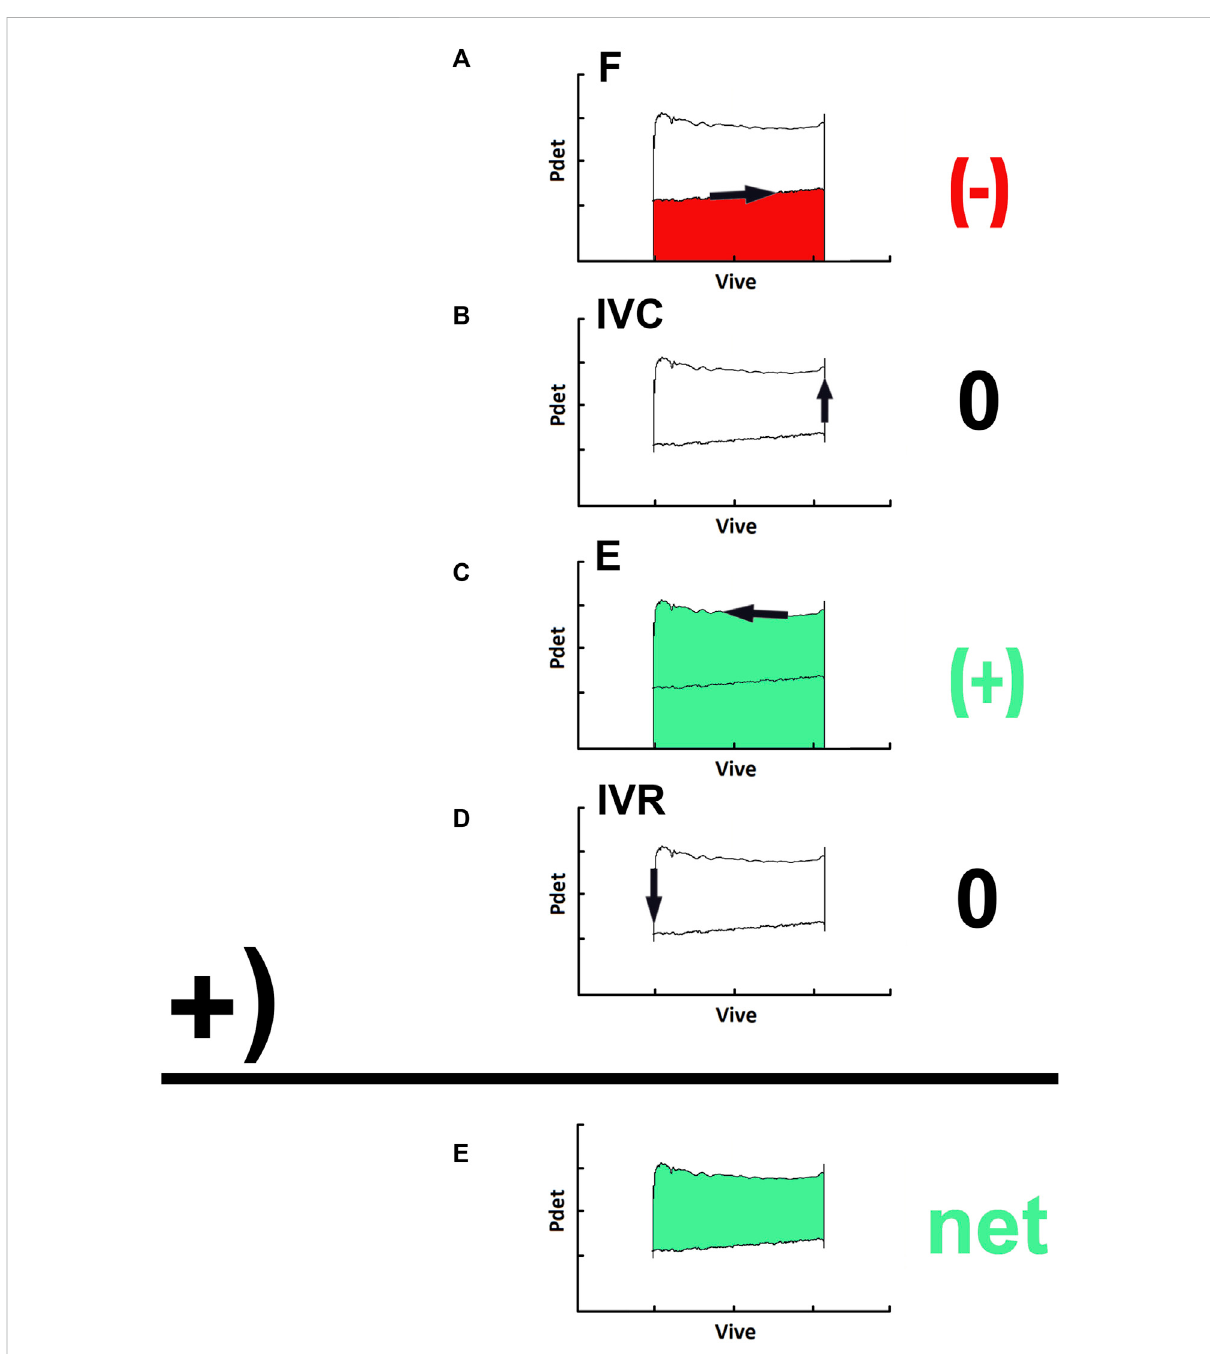
FIGURE 6 Thermodynamic processes in a pressure-volume loop of a voiding. (A) during the fi lling (F), an amount of potential energy represented by the area under the trajectory along the volume change is stored, that is, the output work is negative ( − ; red). (B) in the isovolumic contraction (IVC), the bladder performs no mechanical work, that is, the output work is zero (0). (C) in the emission (E) , the bladder performs a mechanical work characterized by the integration of the trajectory along this stage to repulse fl uid, that is, the output work is positive (+; green). (D) in the isovolumic relaxation (IVR), the bladder gains no mechanical work, that is, the work output is zero (0). (E) the net work done in the entire cyclic process is given by the area enclosed by the loop trajectory of a voiding cycle (net;